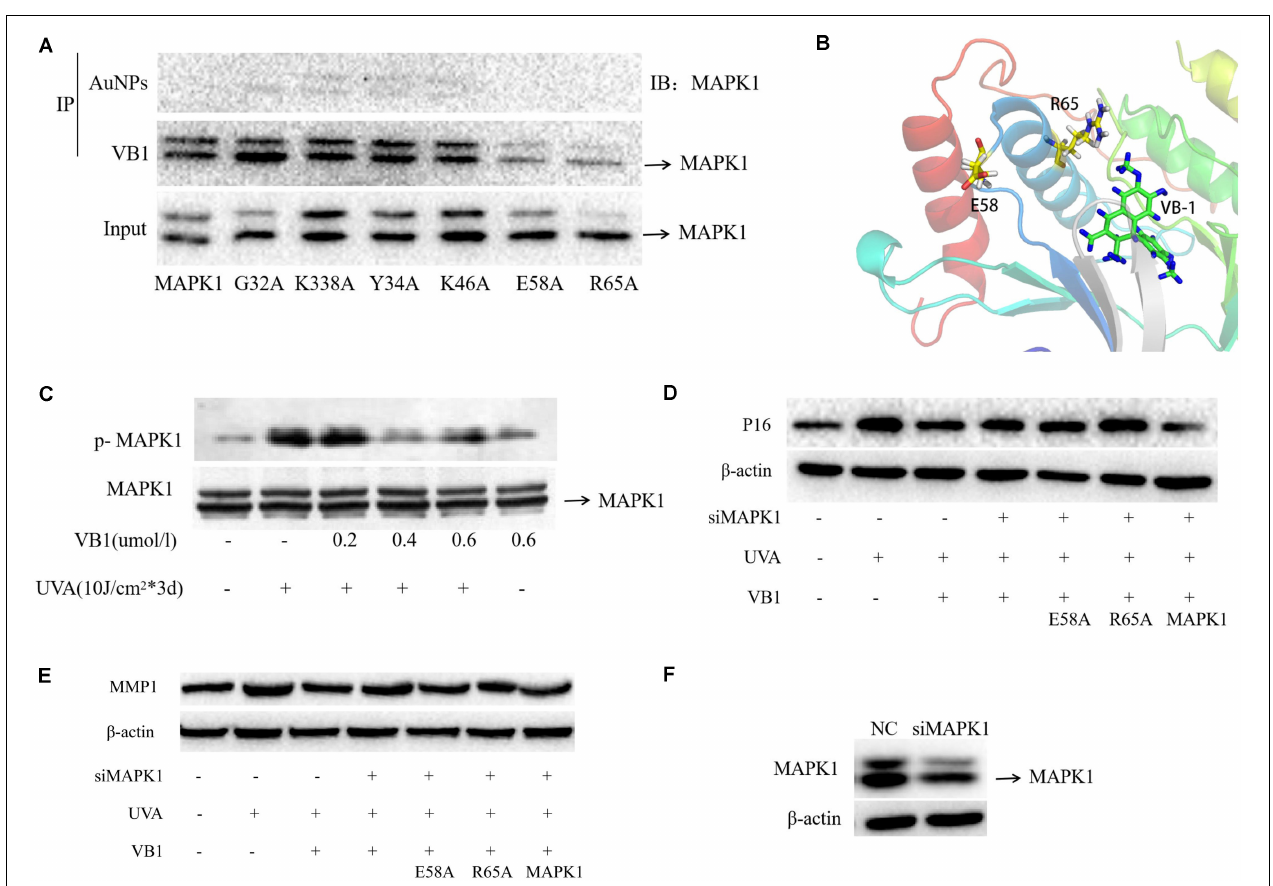
FIGURE 4 | VB1 binds to MAPK1 through E58 and R65 residues of MAPK1 and VB1 protects 293T cells from UVA-induced senescence via binding the two residues. (A) VB1 linked with gold nanoparticles was used for the immunoprecipitation in 293T cells. In the gold nanoparticles (AuNPs) immunocomplexes, MAPK1 was not detectable by western blot analysis, while MAPK1 was detectable by western blot analysis in nanogold-VB1-immunoprecipitated complexes. In the 293T cells transfected with E58-mutant MAPK1 and R65-mutant MAPK1, MAPK1 was not detected, while MAPK1 was detectable in cells transfected with other four mutant MAPK1. (B) The combination form between VB1 and MAPK1 via E58 and R65 residues using computer-aided methods. (C) p-MAPK1 expression was detected by western blot analysis. p-MAPK1 was significantly increased after UVA irradiation and that VB1 could significantly decrease UVA-induced p-MAPK1 expression in a dose-dependent manner. (D,E) 293T cells was used in further co-transfected experiments because of difficulty in HDFs. Endogenous MAPK1 in 293T cells was knockdown by MAPK1 siRNA. Then UVA-irradiated 293T cells were co-transfected with VB1 and wild-type or mutant MAPK1 (E58-mutant or R65-mutant), and p16 and MMP1 expression was detected by western blot analysis. UVA-induced p16 and MMP1 were significantly decreased in 293T cells tranfected with wild-type MAPK1 and VB1, while p16 and MMP1 were partially reversed in 293T cells transfected with E58-mutant or R65-mutant MAPK1 and VB1. (F) MAPK1 siRNA could significantly knockdown the endogenous MAPK1 expression in 293T